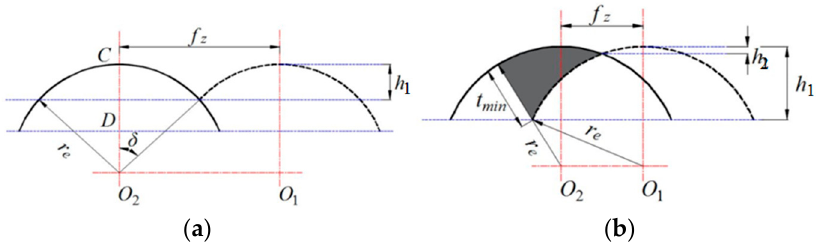
Figure 2. Plane of ideal feed trace of micro groove bottom surface. ( a ) The cutting edge radius is smaller than the feed rate per tooth. ( b ) The cutting edge radius is larger than the feed rate per tooth .